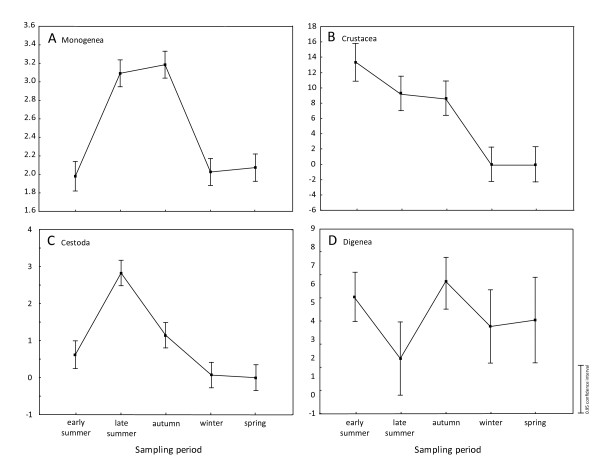
The changes in parasite abundance in relation to sampling period. Detailed legend: The changes in abundance of (A) Monogenea, (B) Crustacea, (C) Cestoda and (D) Digenea in relation to sampling period. Log transformation for abundance of Monogenea and hyperbolic arcsine square root transformation for Cestoda were applied.